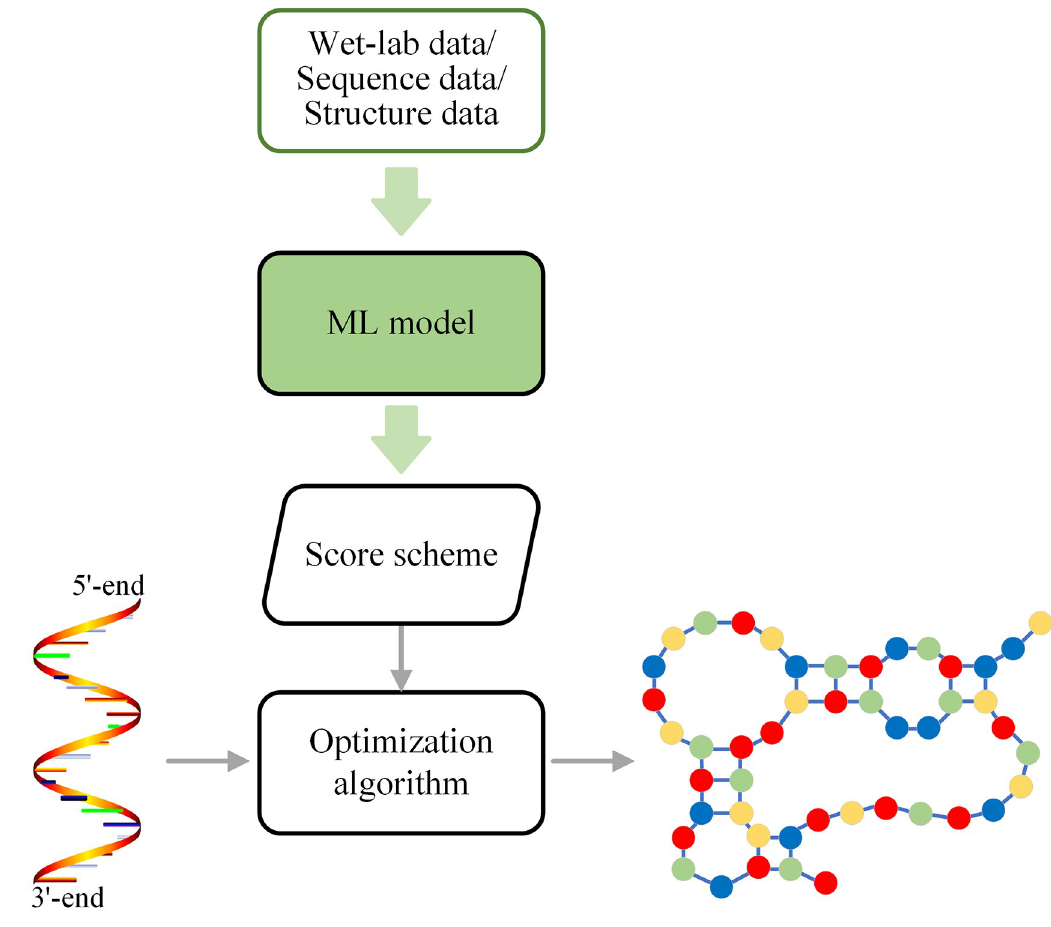
Fig 2. Framework for RNA secondary structure prediction methods with ML-based score schemes. Wet lab data, RNA sequence data, or RNA structure data can be employed to train an ML model to obtain a score scheme. Using this score scheme, an RNA secondary structure can be predicted using a traditional score-based approach from a single RNA